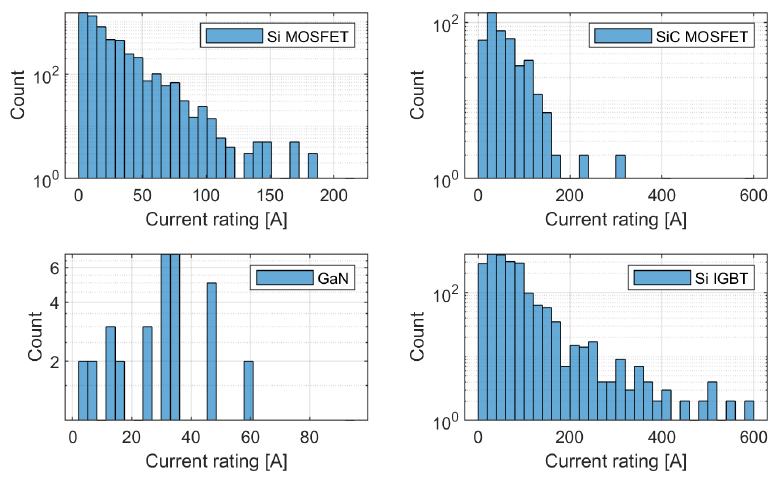
Figure 35. Distribution of power semiconductors (>400 V) by current rating.